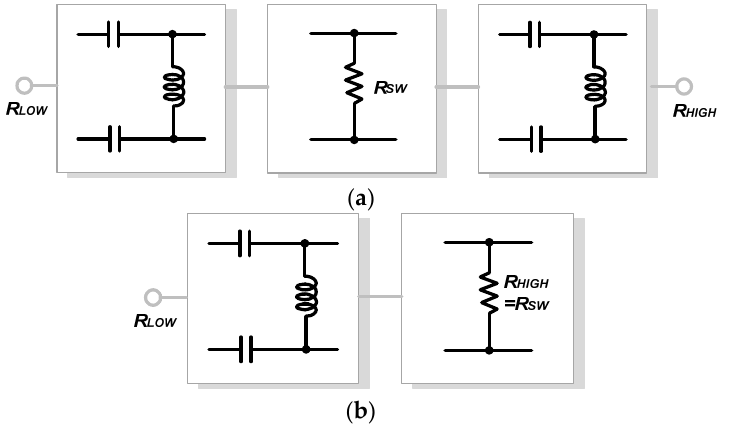
Figure 5. Impedance matching networks from output of the PA to antenna. ( a ) Multi-section matching. ( b ) Single-section matching.